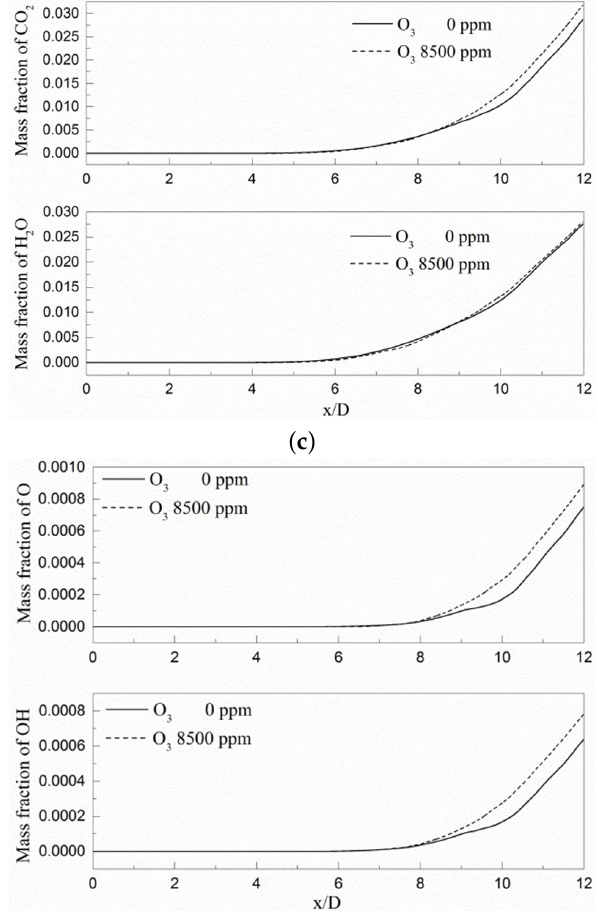
Figure 4. The time-averaged velocity, temperature, fuel, product, and intermediate product OH and O radical mass fraction distribution on the central axis. ( a ) The time-averaged velocity and temperature, ( b ) mass fraction of H 2 and CO, ( c ) mass fraction of H 2 O and CO 2 , and ( d ) mass fraction of O and